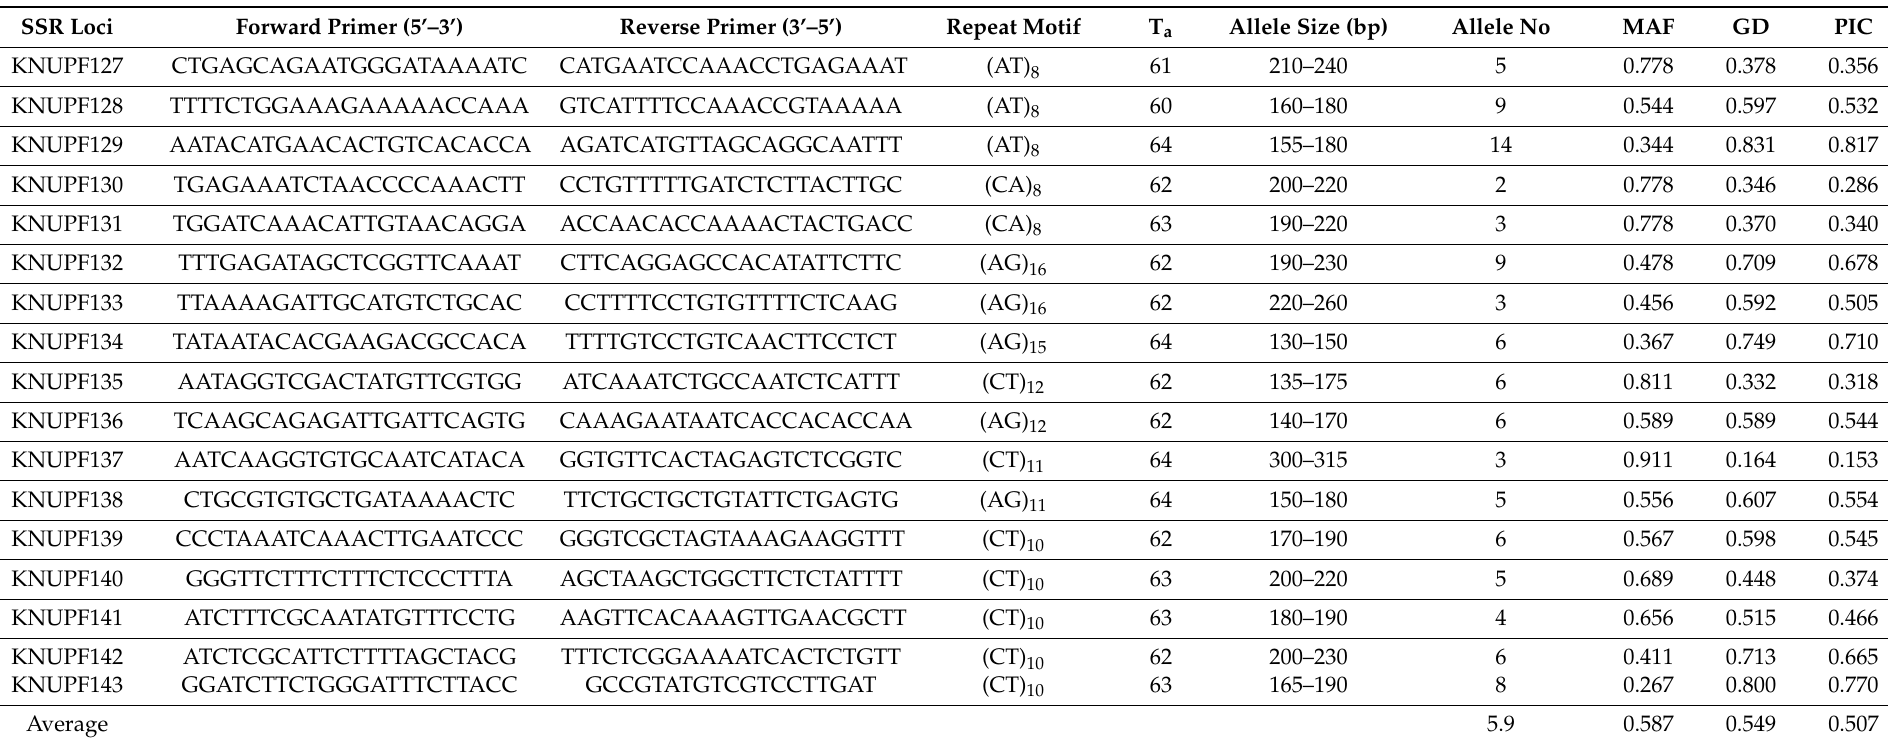
Table 1. Characteristics of the 17 SSR loci including primer sequence, repeat motif, annealing temperature, allele size range, genetic diversity index among 90 Perilla